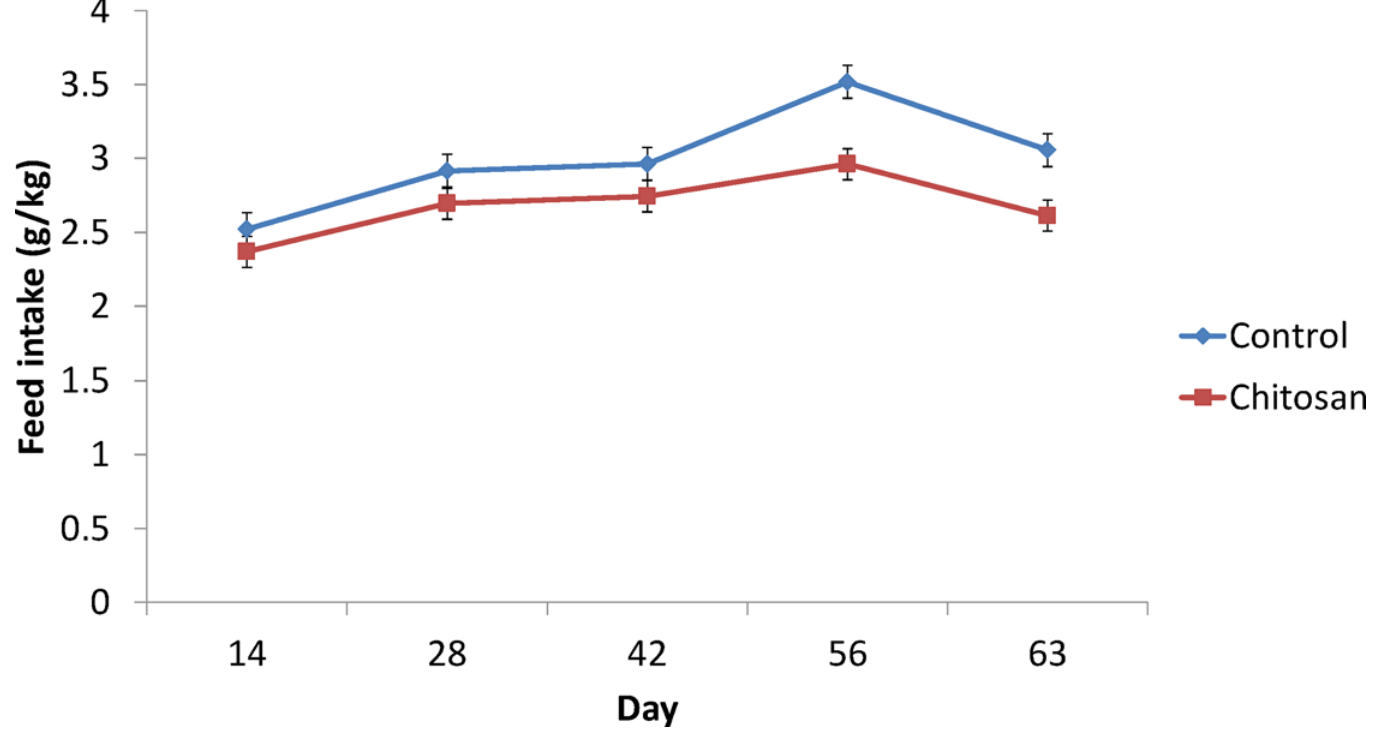
Fig 2. Effect of dietary supplementation on feed intake over time at days 0, 14, 28, 42, 56 and 63. Treatment effect P < 0.001. Time effect P < 0.001. Values are means, with their standard errors represented by vertical bars.